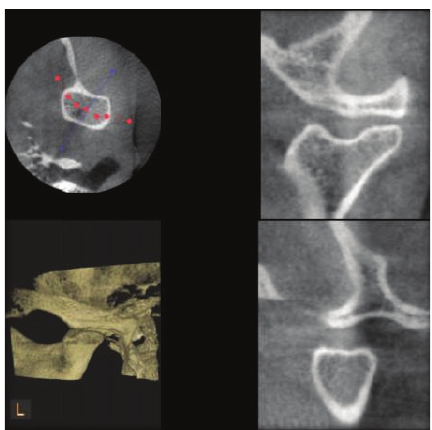
Figure 7: Sclerosis of condyle as seen in DVT.